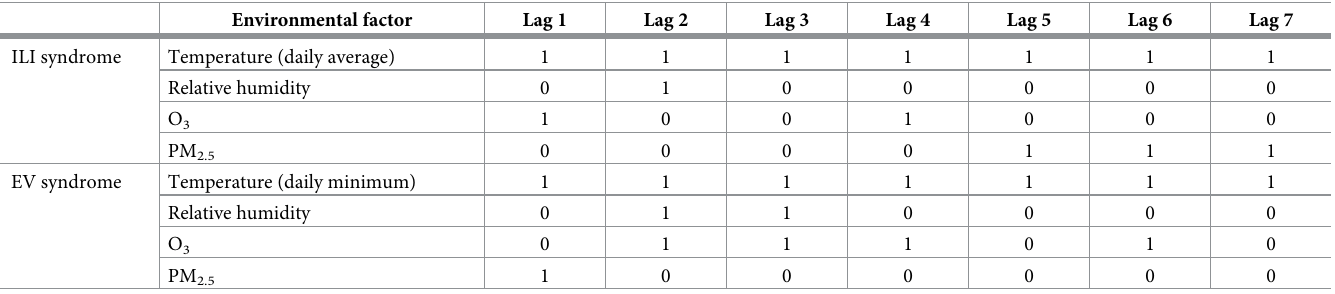
Table 2. The lag-response functions of environmental factors for daily ILI syndromic